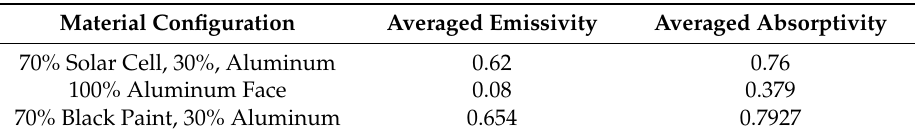
Table 30. Initial Material Properties for Steady-state